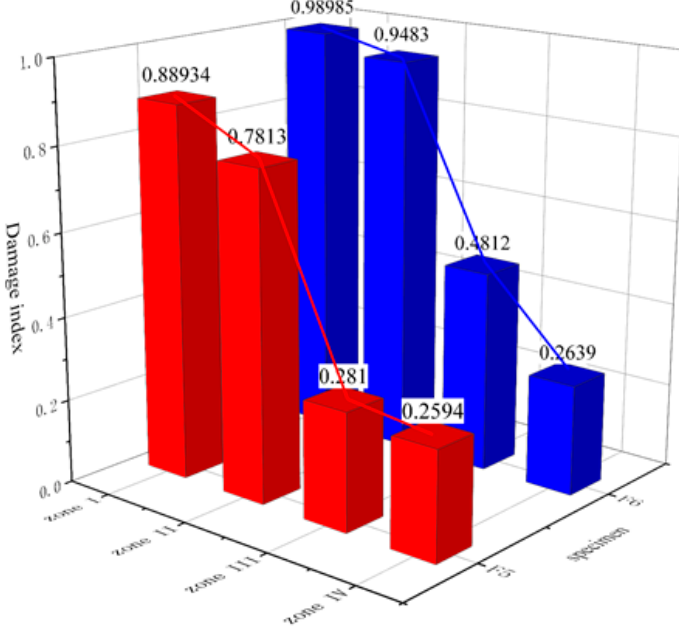
Figure 14. Average damage index of each zone.